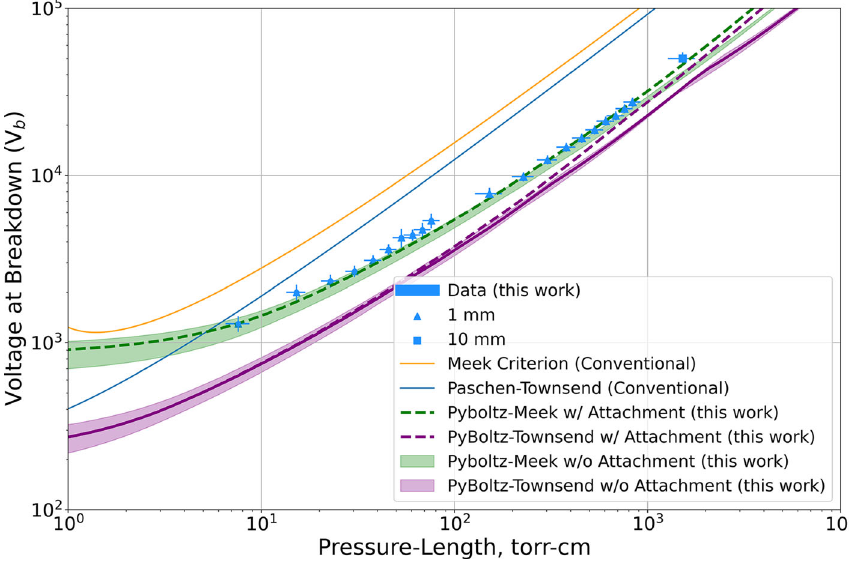
Fig. 6 CO 2 breakdown voltage vs. pressure-length data plotted alongside the theoretical curves